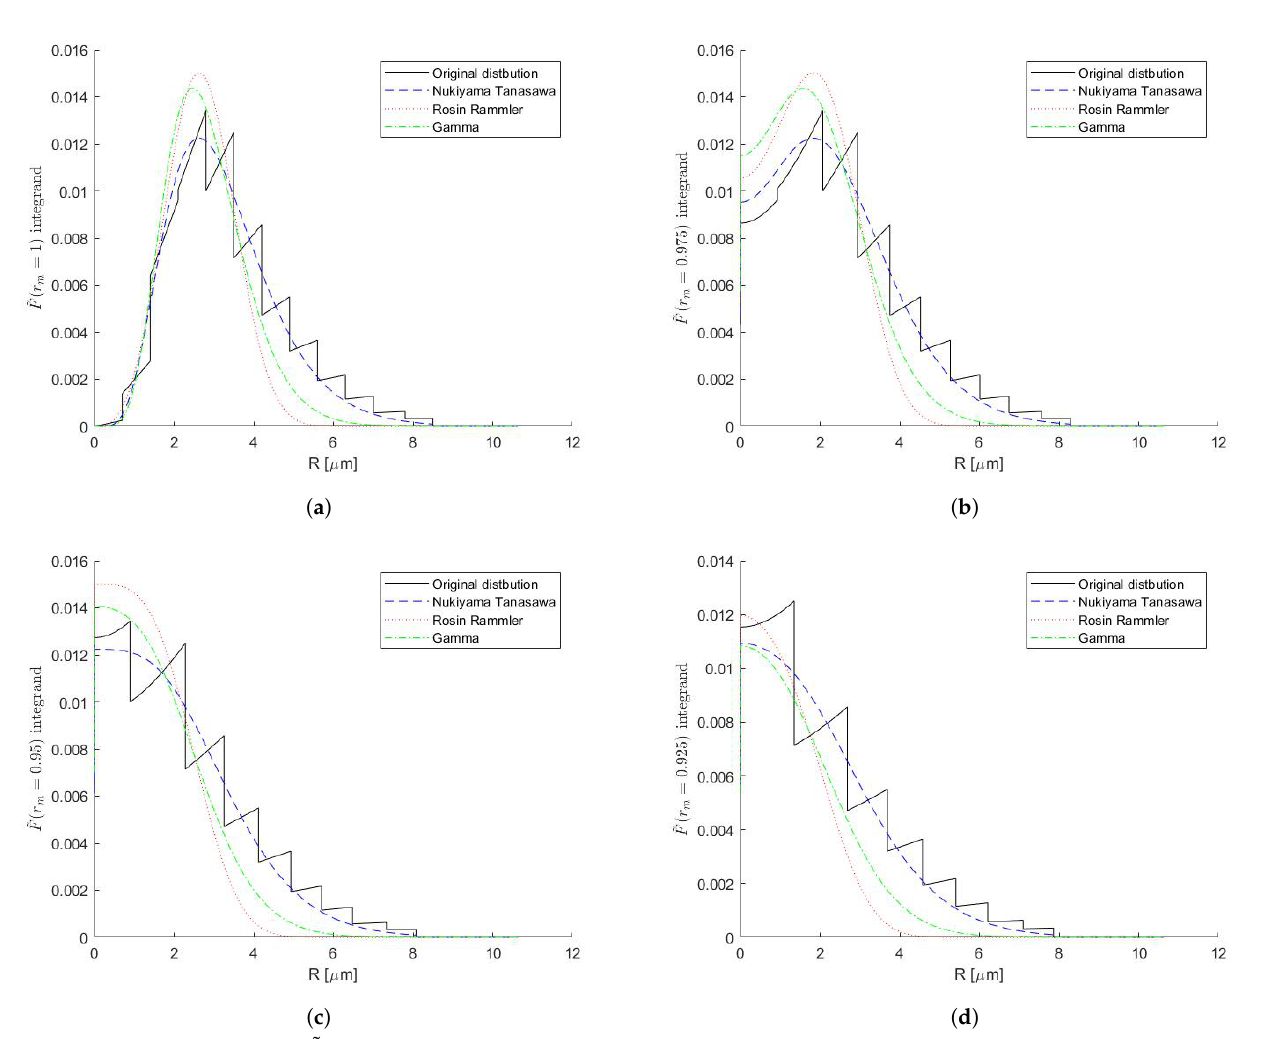
Figure 2. The integrand of ˜ F given by Equation (13) in the region near r m = 1 for experimental data and its approximations (Nukiyama–Tanasawa, Rosin–Rammler, and gamma distributions), at various values of r m . ( a ) The integrand of ˜ F at r m = 1. ( b ) The integrand of ˜ F at r m = 0.975. ( c ) The integrand of ˜ F at r m = 0.95. ( d ) The integrand of ˜ F at r m = 0.925.